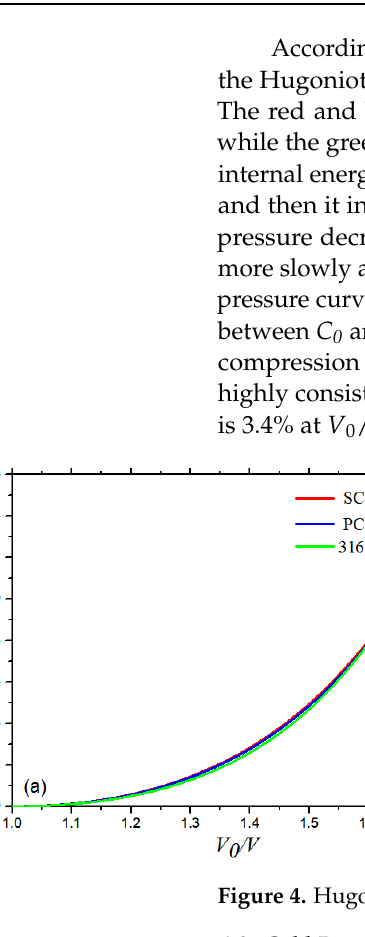
Table 3. Material constants of 316 stainless steel.